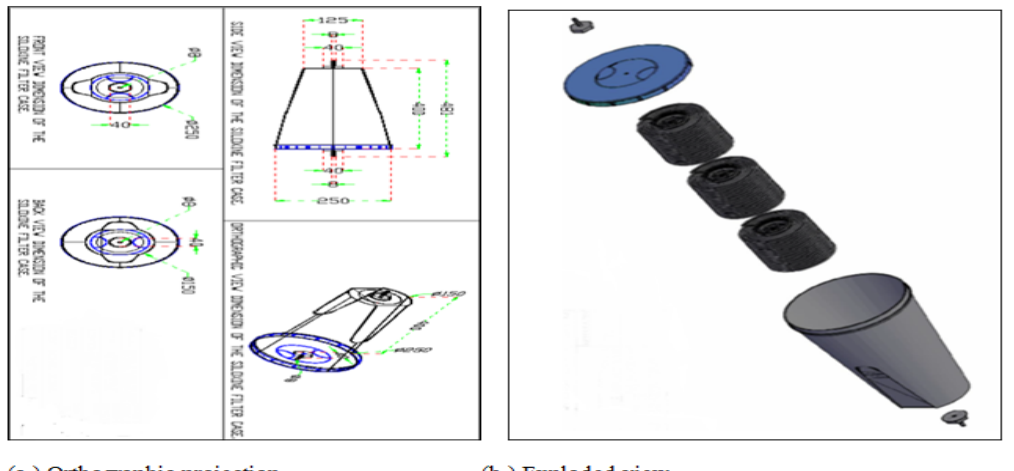
Fig. 4. Orthographic projection and exploded view